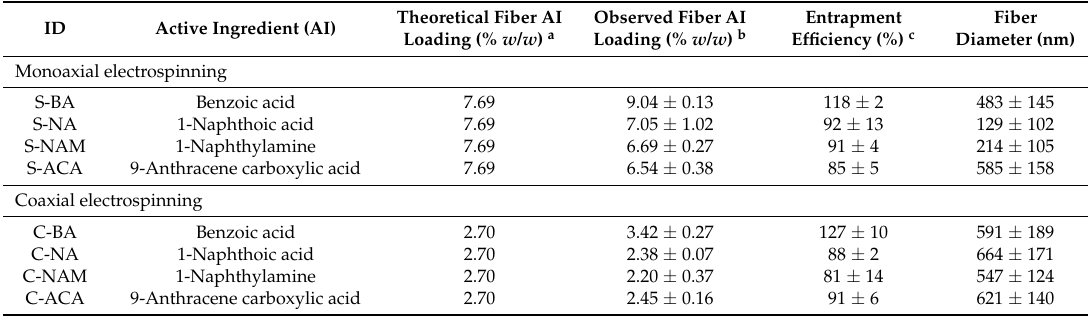
Table 1. Details of the electrospun formulations prepared in this